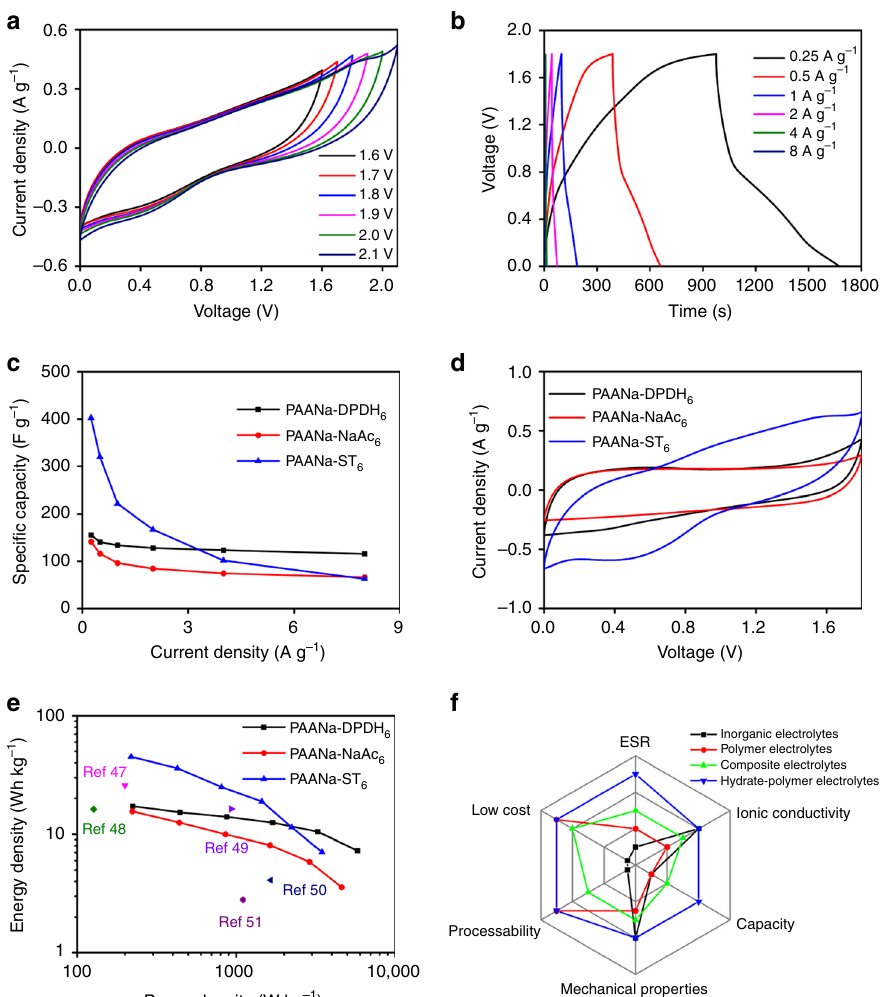
Fig. 4 Electrochemical performance of PCCEs-based supercapacitors. a Cyclic voltammetry curves of the PAANa-ST 6 -based supercapacitor with different cut-off voltages from 1.6 to 2.1 V. b Galvanostatic charge – discharge curves of the PAANa-ST 6 -based supercapacitor with different current density. c Speci fi c capacitance of the supercapacitors with different hydrate – polymer composite electrolytes at various current densities. d Cyclic voltammetry curves of supercapacitors based on the PAANa-ST 6 , PAANa-DPDH 6 , or PAANa-NaAc 6 composites at a sweep speed of 5 mV s − 1 . e Ragone plot of the supercapacitors with different electrolytes. f The radar plots of the comprehensive performances of different